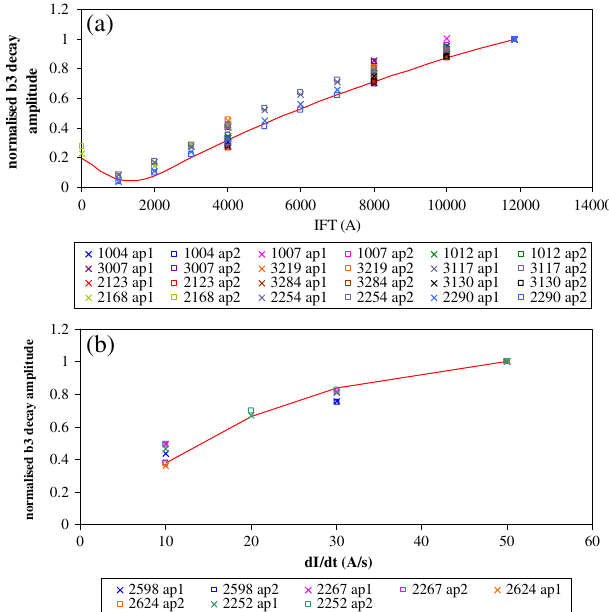
dI=dt . Figures are reported for the first FT and ramp rate two allowed harmonics (sextupole b 3 and decapole b 5 ), for